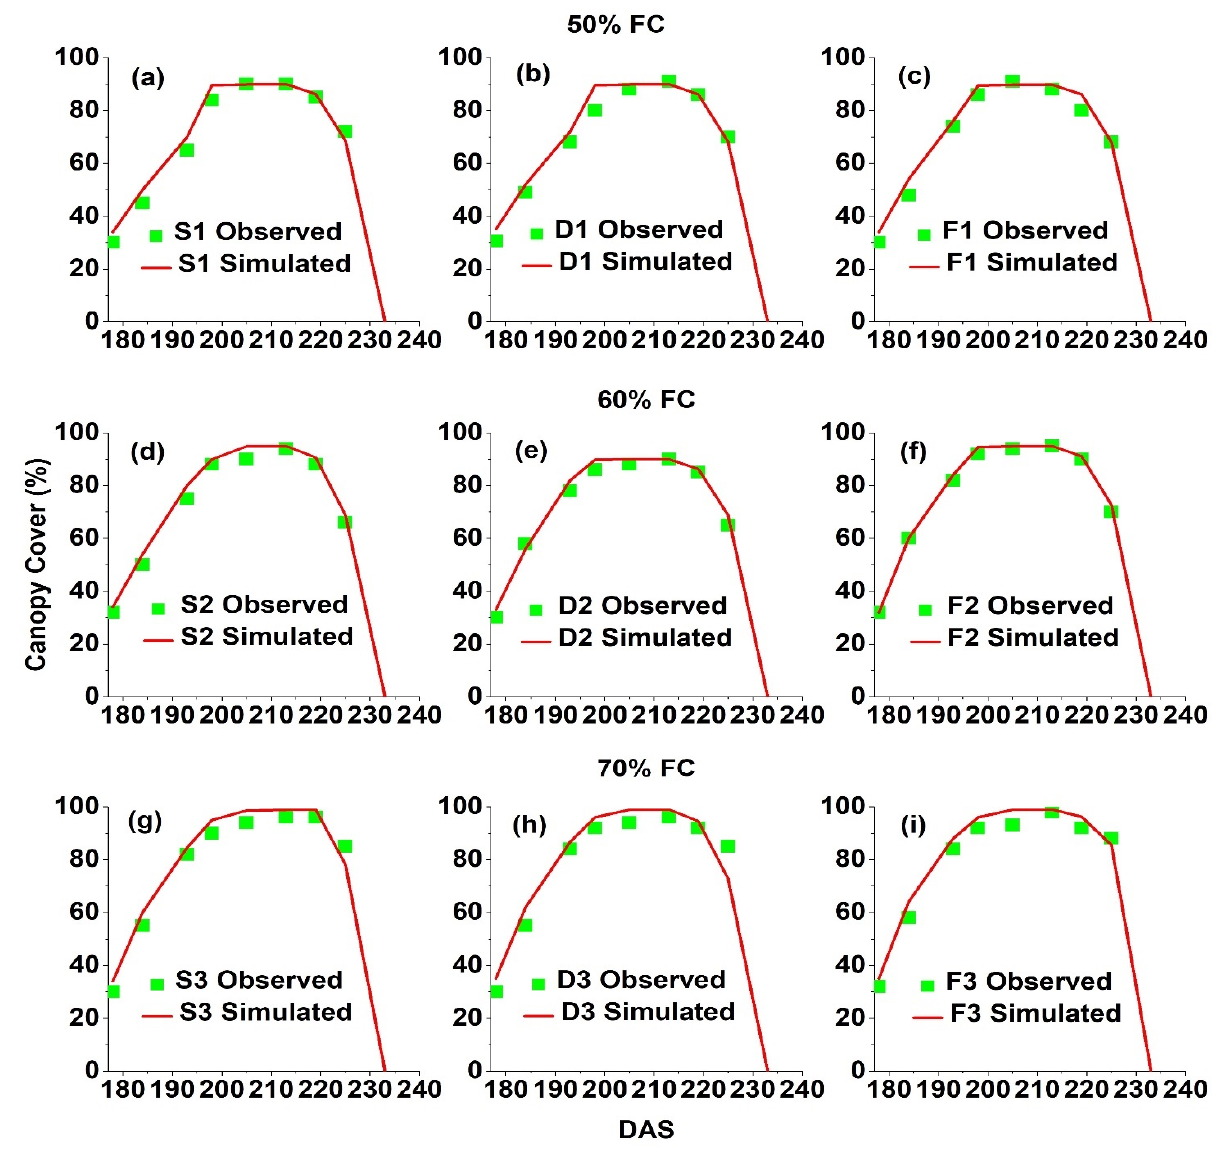
Figure 3. Calibration results of canopy cover (%) of winter wheat at 50% FC ( a – c ), 60% FC ( d – f ), and 70% FC ( g – i ) under the sprinkler, drip, and flood irrigation system in 2016–2017. Note: S1: sprinkler irrigation at 50% FC, D1: drip irrigation at 50% FC, F1: flood irrigation at 50% FC, S2: sprinkler irrigation at 60% FC, D2: drip irrigation at 60% FC, F2: flood irrigation at 60% FC, S3: sprinkler irrigation at 70% FC, D3: drip irrigation at 70% FC, F3: flood irrigation at 70% FC. The simulated grain yield varied from 8.52 t ha − 1 (F1) to 9.68 t ha − 1 (D3) (Table 5). The prediction error for grain yield ranged from − 2.72% (S2) to 3.30% (D1). The CRM values at 50%, 60%, and 70% FC for grain yield were − 0.03, 0.02, and − 0.03, respectively. The RMSE for grain yield ranged from 0.19 (60% FC) to 0.25 t ha − 1 (70% FC), while the NRMSE for grain yield varied from 2.10 (60% FC) to 2.75% (70% FC). The R 2 and d-index for grain yield were 0.80 and 0.92, respectively, combined for all treatments (Figure 4b).